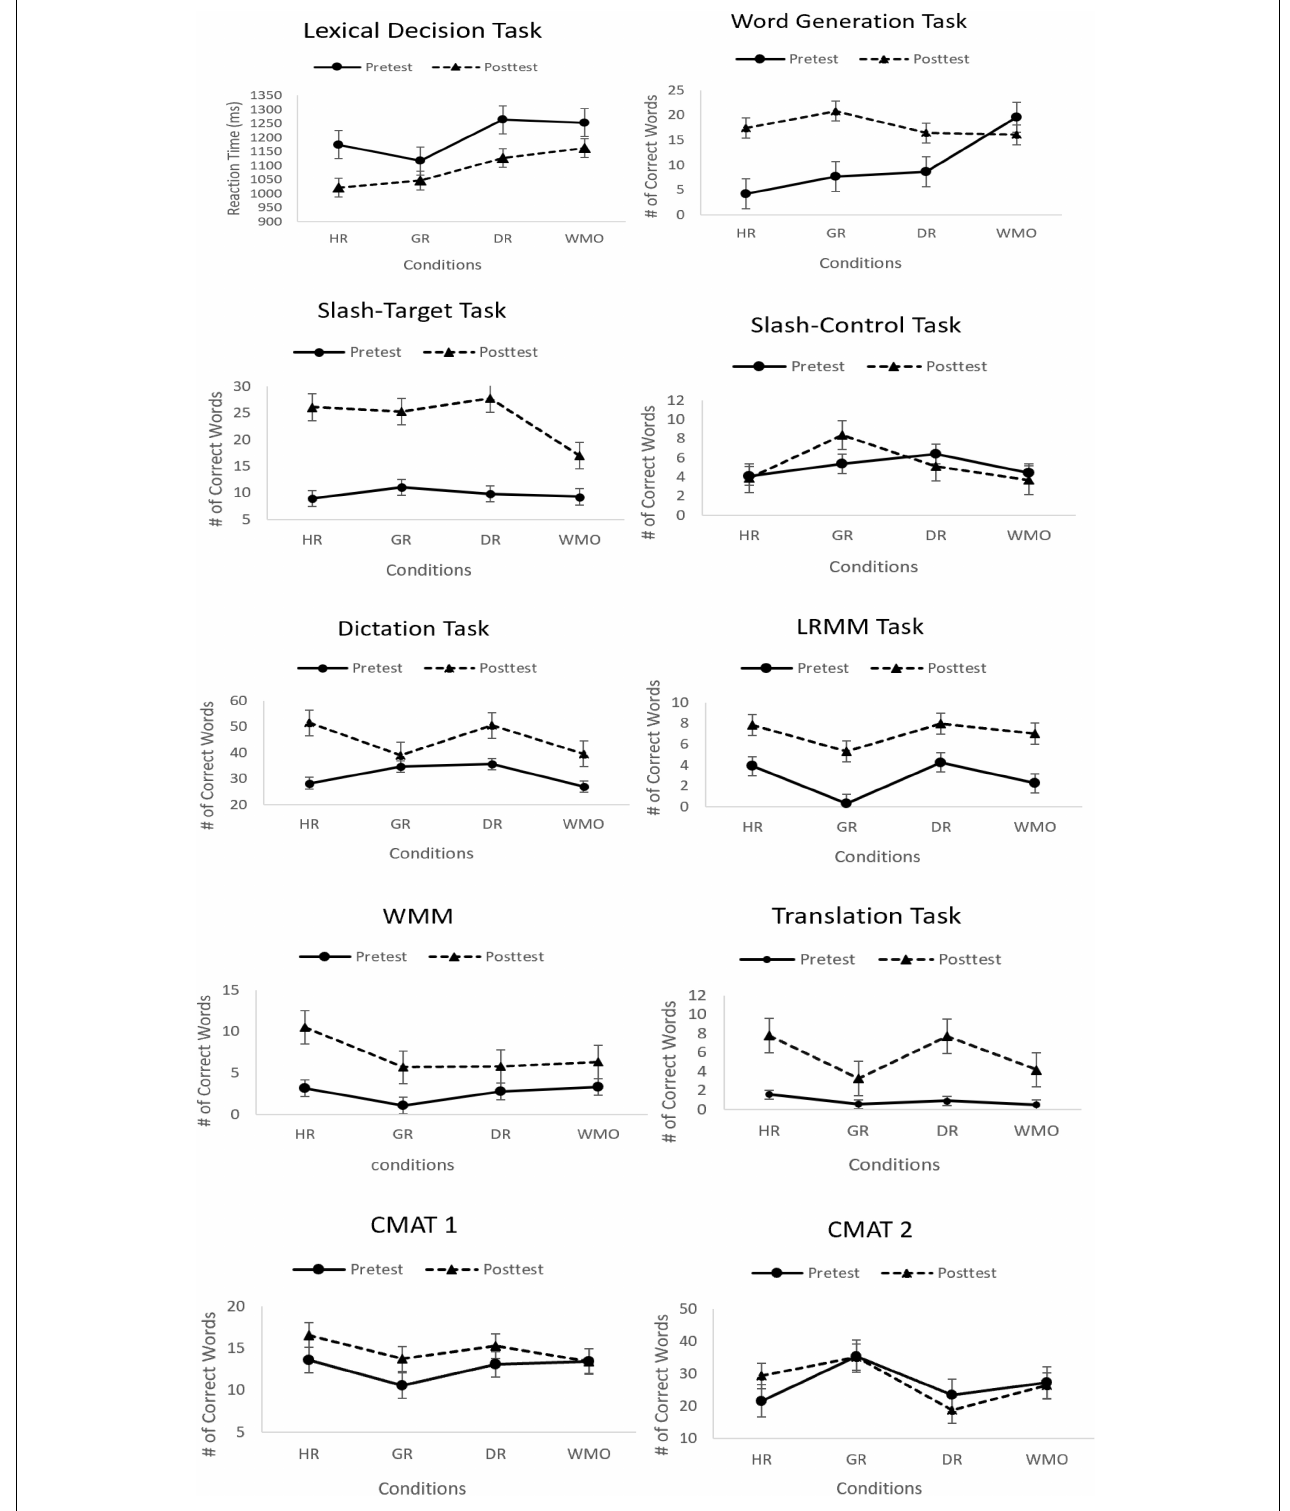
FIGURE 2 | Model-predicted accuracy for eight measures as a function of the partial effects of item-level (pre vs. post) and participant level (four conditions) properties. Error bars depict 95% confidence intervals across subjects. HR, handwrite root; GR, gesture root; DR, dragging root; WMO, word meaning only; LRMM, latin root meaning-matching; WMM, word meaning-matching; CMAT, Chinese morphological awareness task.